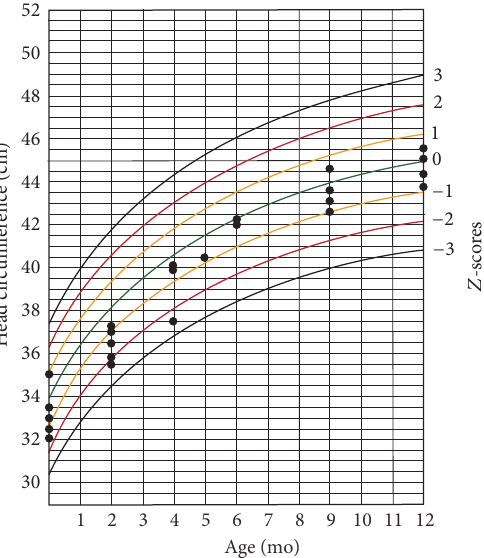
Figure 4: Head circumference-for-age chart for girls during one- year